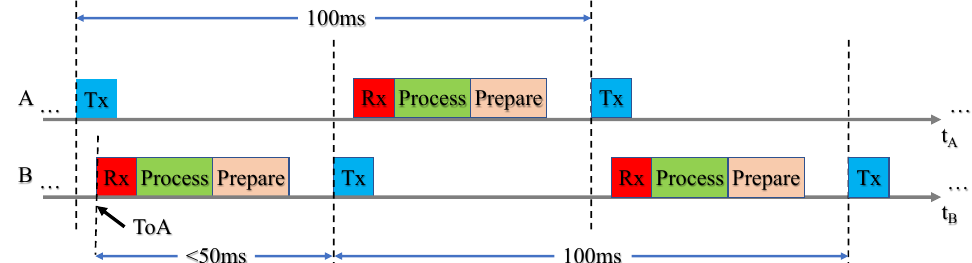
Figure 4. Depiction of the data link layer for two users labeled A and B . These users alternate transmitting and receiving every 50 ms. To ensure that the appropriate timing information is shared in the next frame, each user must finish executing their processing chain before the next